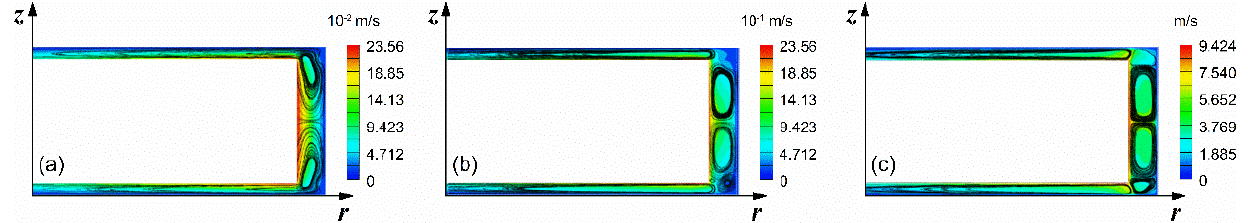
Figure 10. Distribution of the Taylor turbulence at different Re. ( a ) Re = 1.75 × 10 3 ; ( b ) Re = 1.75 × 10 4 ; ( c ) Re = 7.02 × 10 4 .